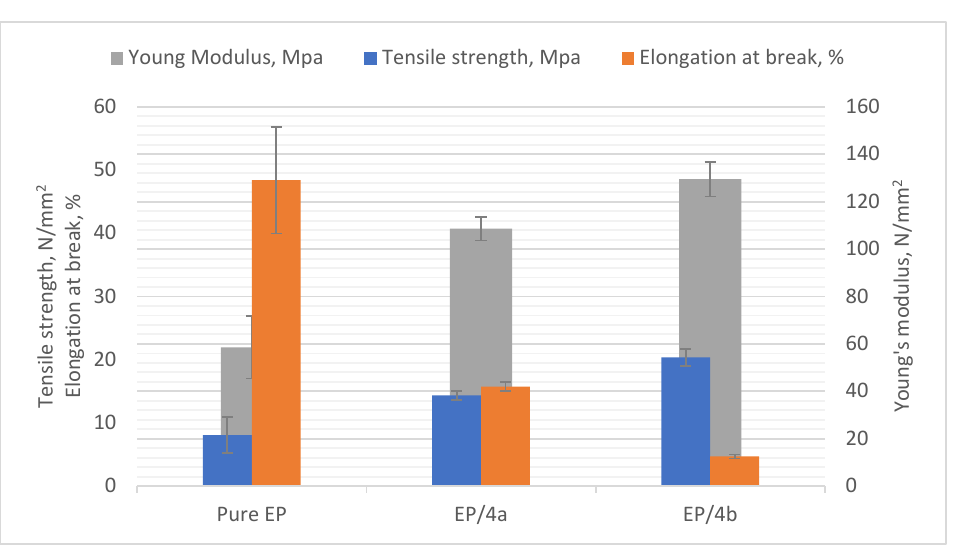
Figure 10. Mechanical properties of EP, and EP with FR additives.